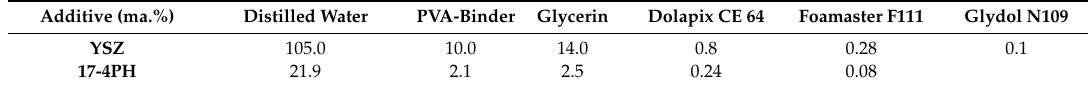
Table 2. Suspension composition of YSZ and